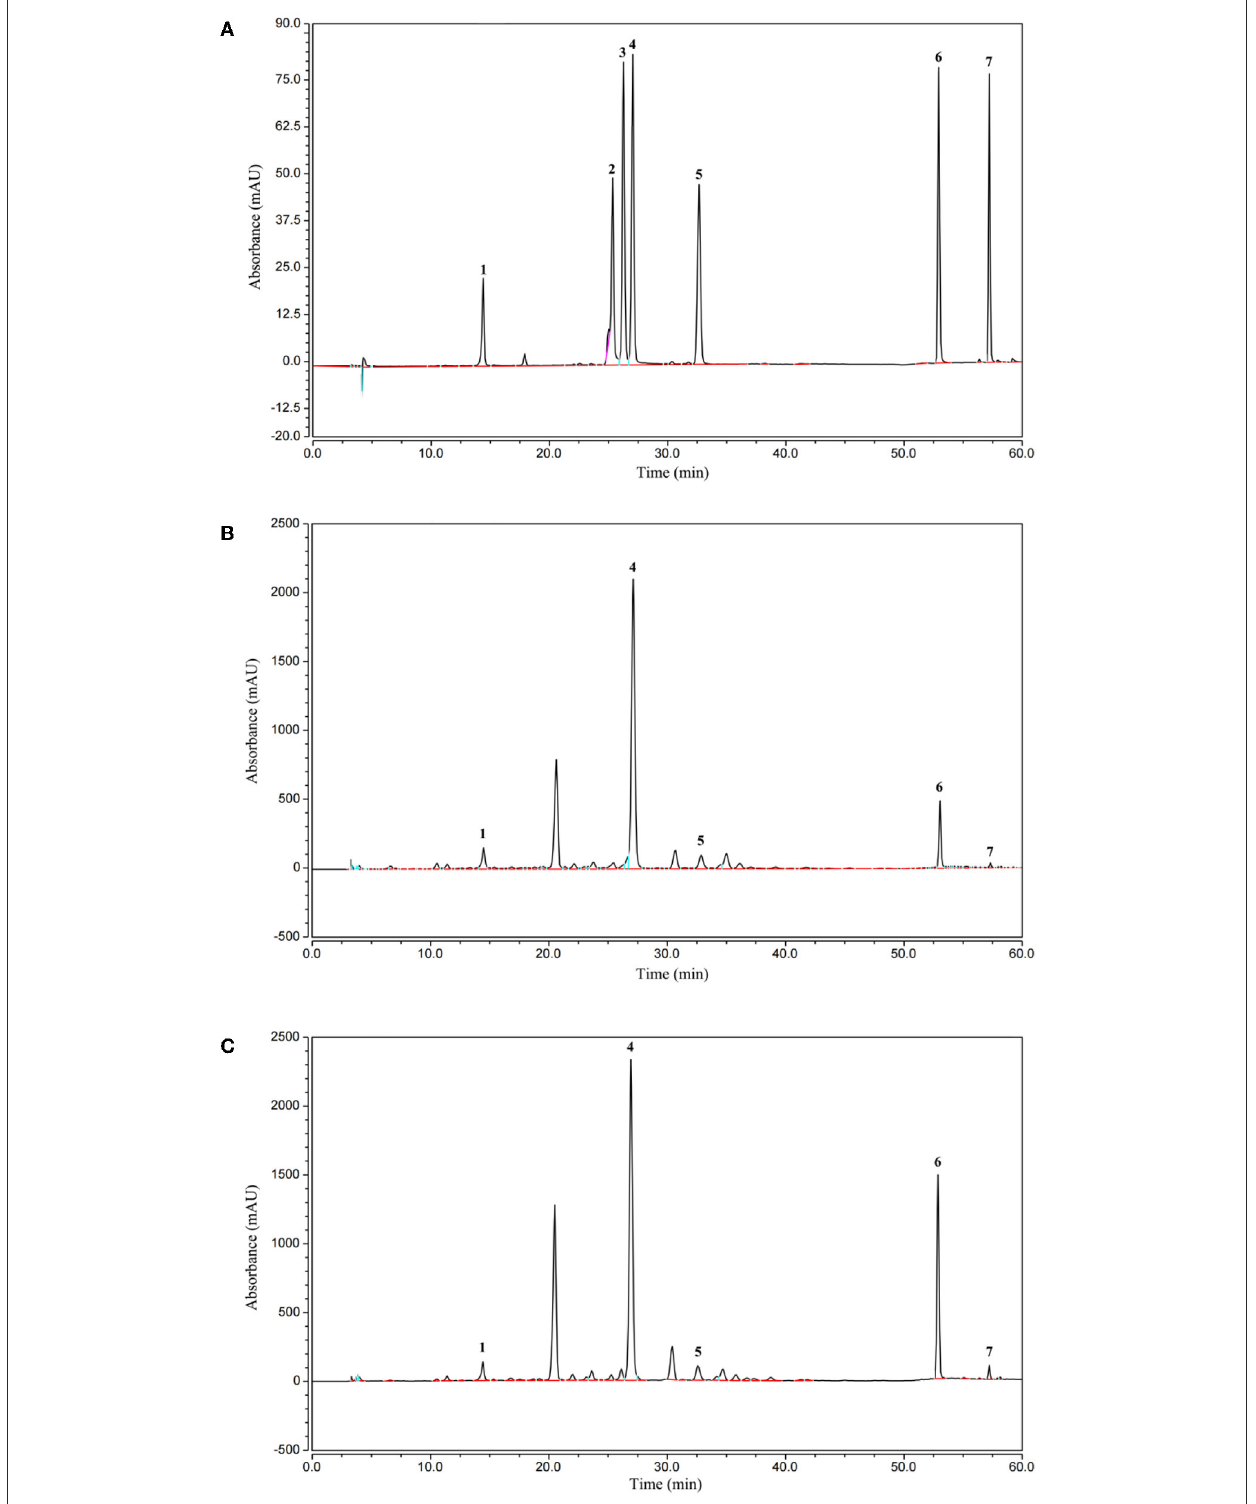
FIGURE5 High-performance liquid chromatography (HPLC) chromatogram of the standard compounds (A) , native (B) , and fermented phenolics (C) in the EA subfraction of AVL, Peaks: 1, Chlorogenic acid; 2, Rutin; 3, quercetin-3- O -galactoside; 4, Isoquercitrin; 5, kaempferol-3- O -glucose; 6, Quercetin; 7,